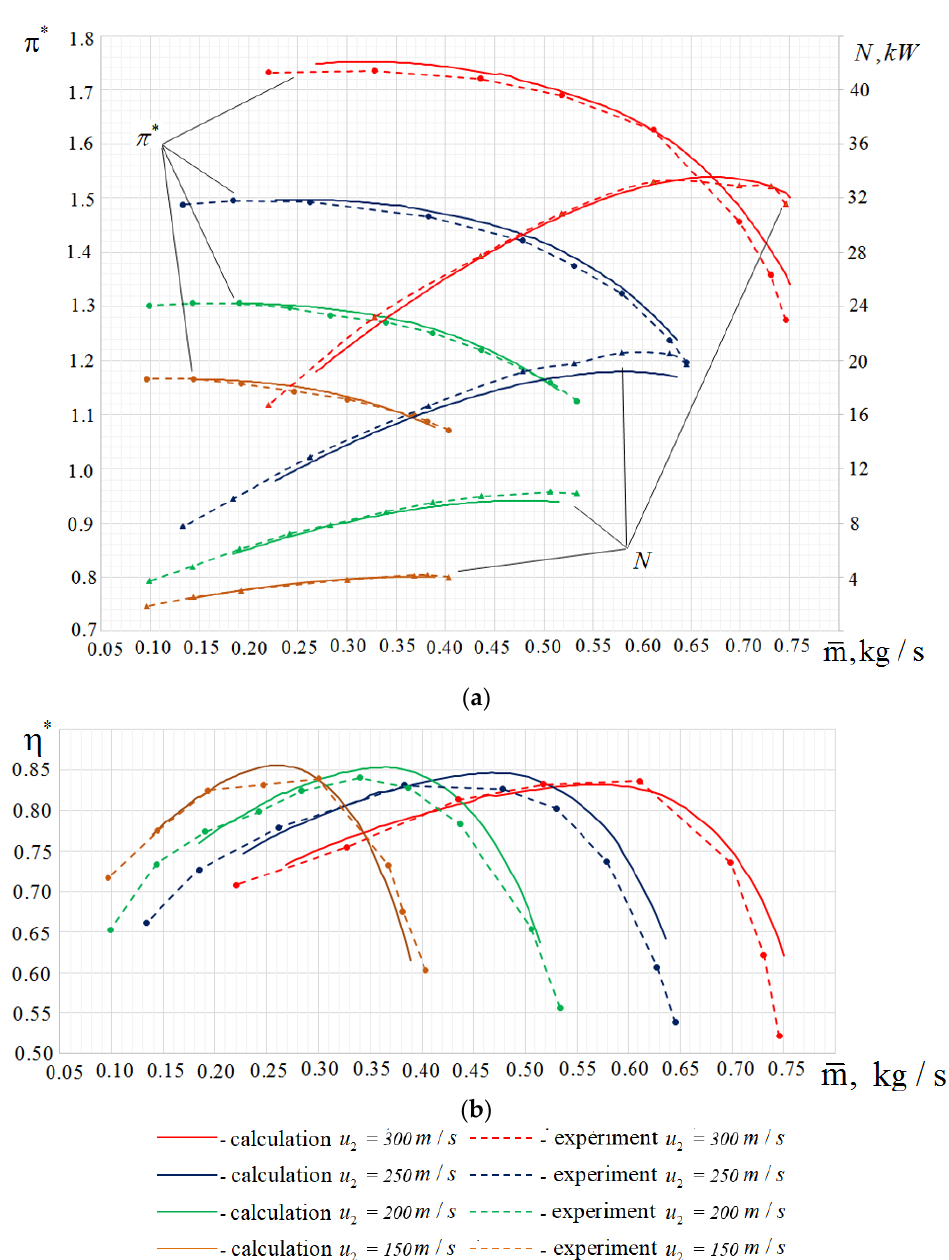
Figure 14. Comparison of the 140E compressor’s characteristics obtained during the experiment and the calculation at impeller velocity u 2 = 150, 200, 250, and 300 m / s: ( a ) gas-dynamic characteristic of total pressure ratio and power; ( b ) gas-dynamic characteristic of efficiency.